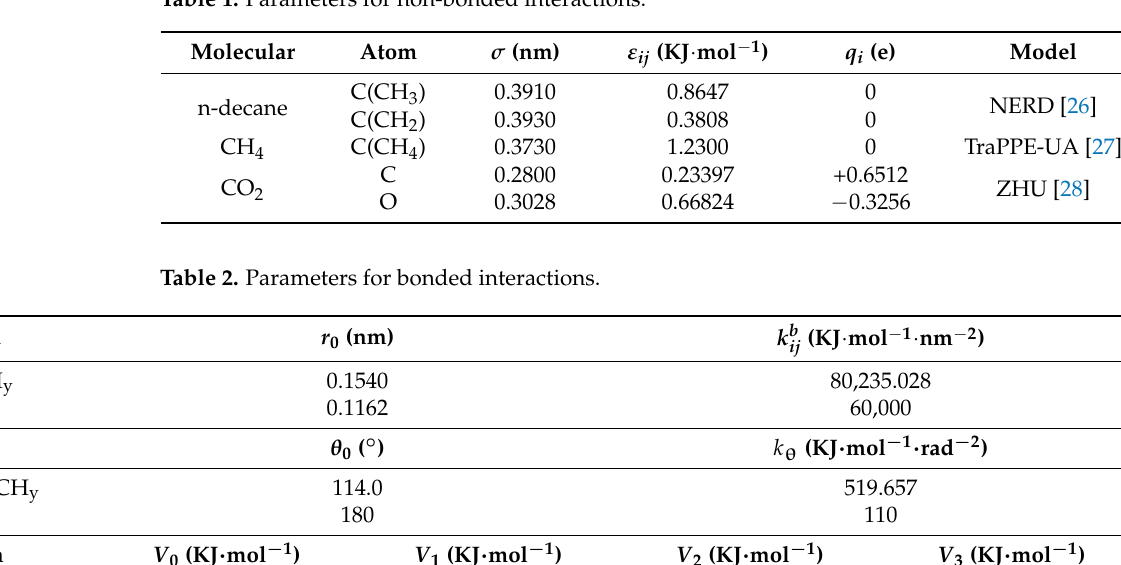
Table 1. Parameters for non-bonded interactions.